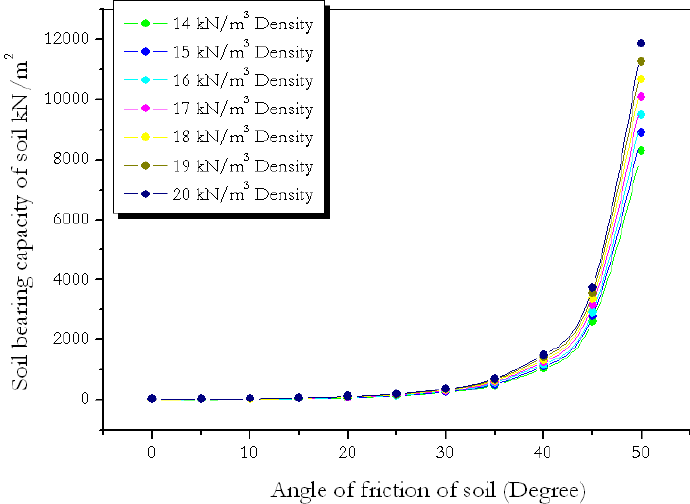
Figure 2: Safe bearing capacity Vs angle of friction of